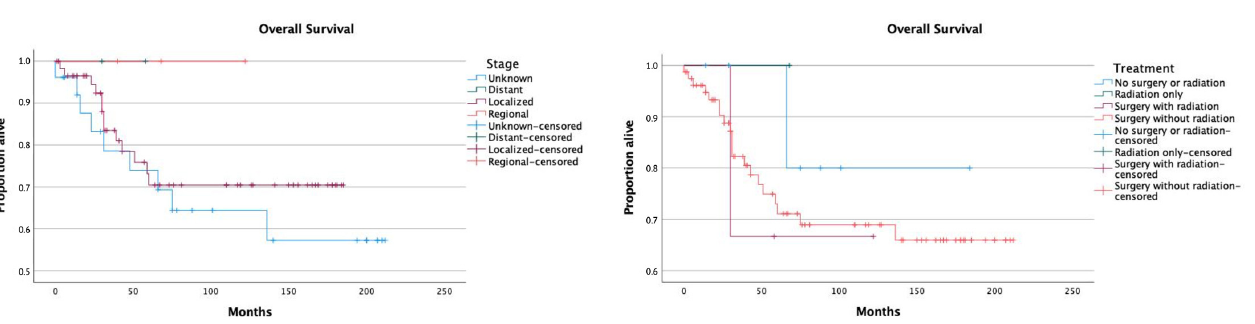
Figure 2. Survival distribution according to disease stage and treatment modalities.